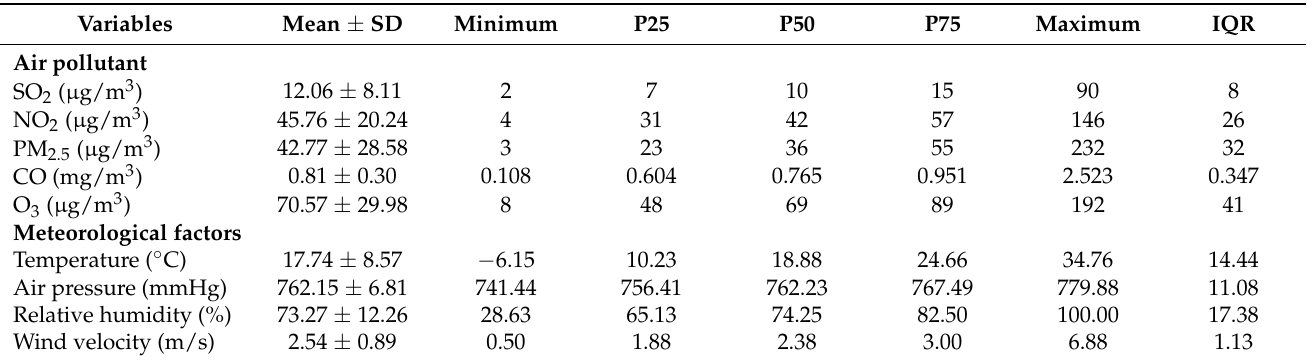
Table 1. Summary statistics for daily air pollutants and meteorological data in Xuhui District, Shanghai, 2014–2019.